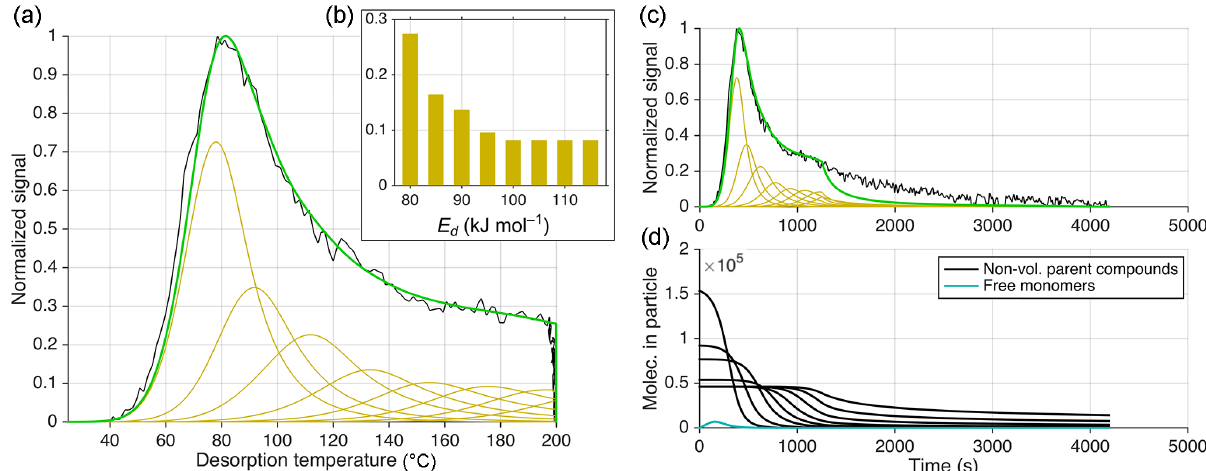
Figure 10. Equivalent to Fig. 9 but presenting the results of using approach 2 (out of three) for reproducing the observed thermogram. All C 8 H 12 O 5 molecules are formed from irreversible thermal decomposition of non-volatile material, following the Arrhenius relation (see text) using a set of eight activation energies ( E d ), ranging from E d = 80 to 115kJmol − 1 . Their subsequent evaporation is modeled using = 2µgm − 3 , (cid:49)H = 80kJmol − 1 , and α = 1, i.e., practically not limiting. Assumed relative contributions of each E C ∗ 0 (Note the consequently different units for the abscissa in b compared to Figs. 9 and 11.) (d) shows the abundances of the corresponding non-volatile parent compounds still in the particle vs. time (black).